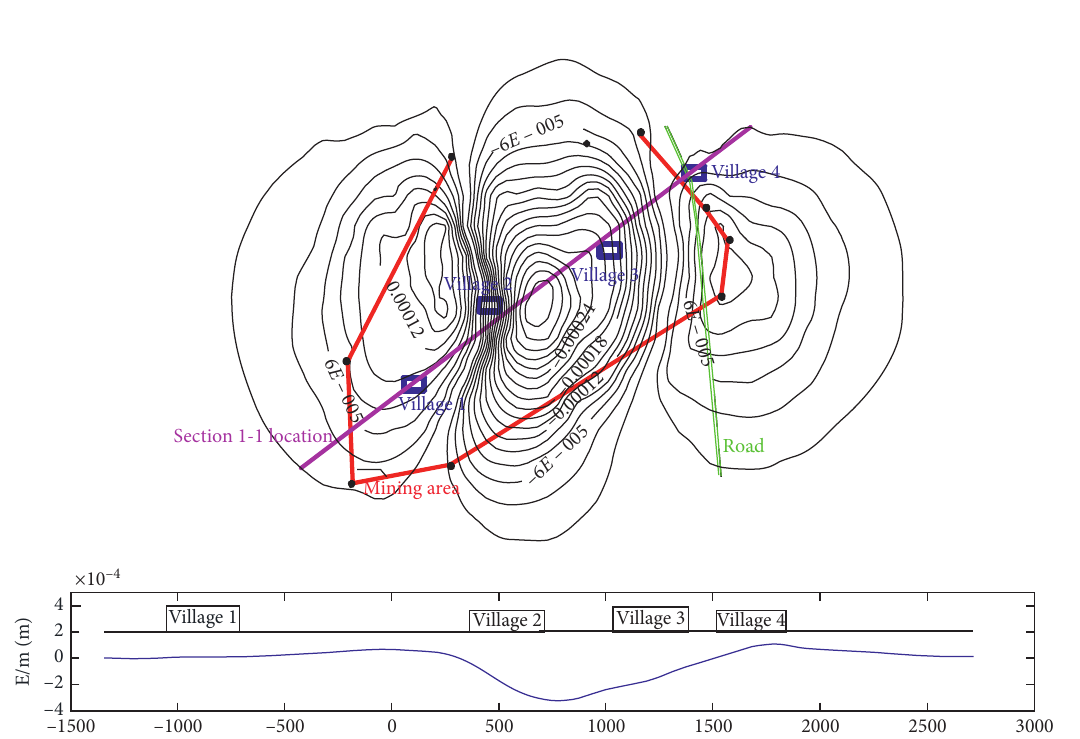
Figure 17: Contour map of surface horizontal